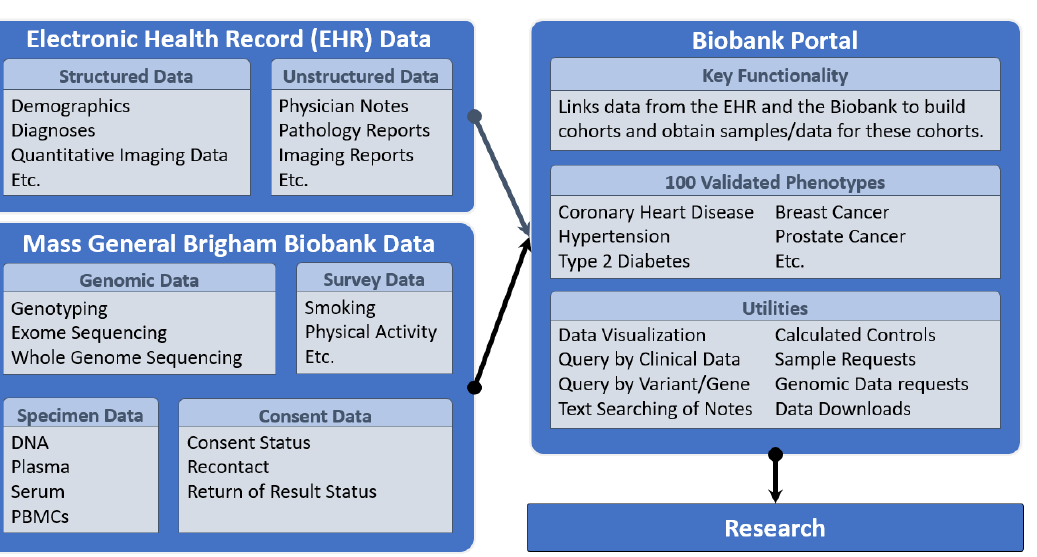
Figure 3. Biobank Portal Data Integration for Automated Access to Clinical Data.